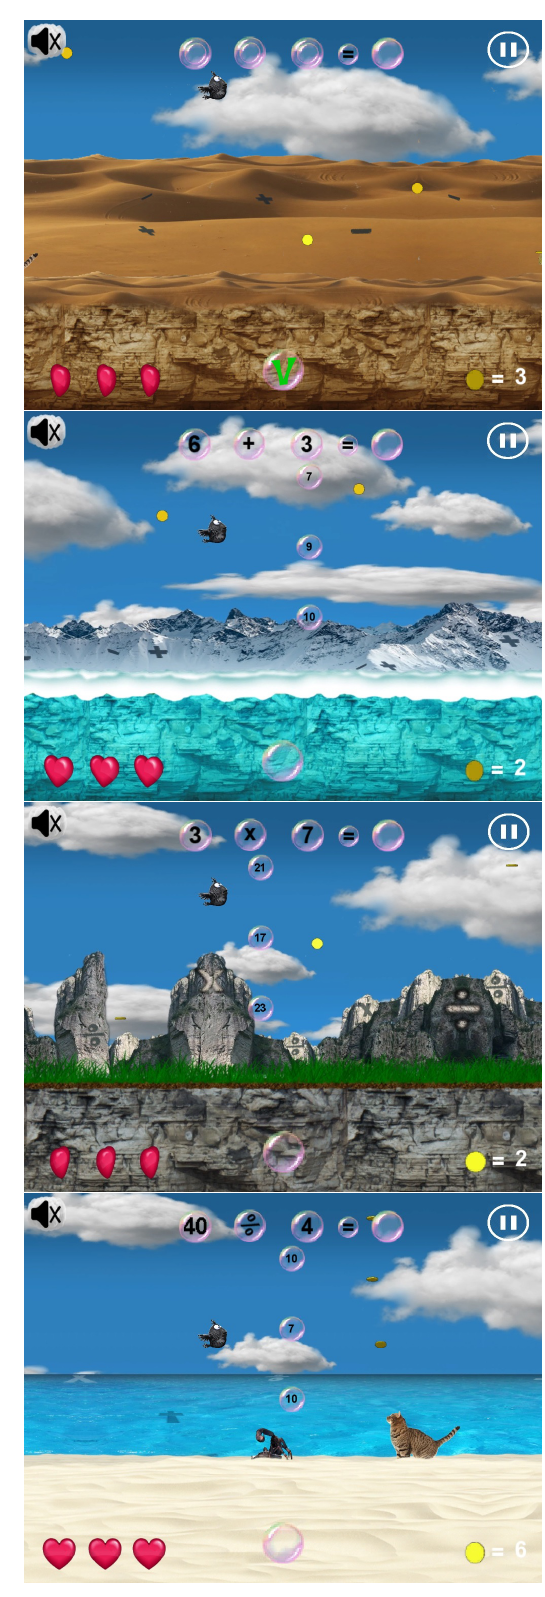
Figure 4. The four scenarios of the game. (a) Scenario of the first medal. (b) Scenario of the second medal. (c) Scenario of the third medal. (d) Scenario of fourth